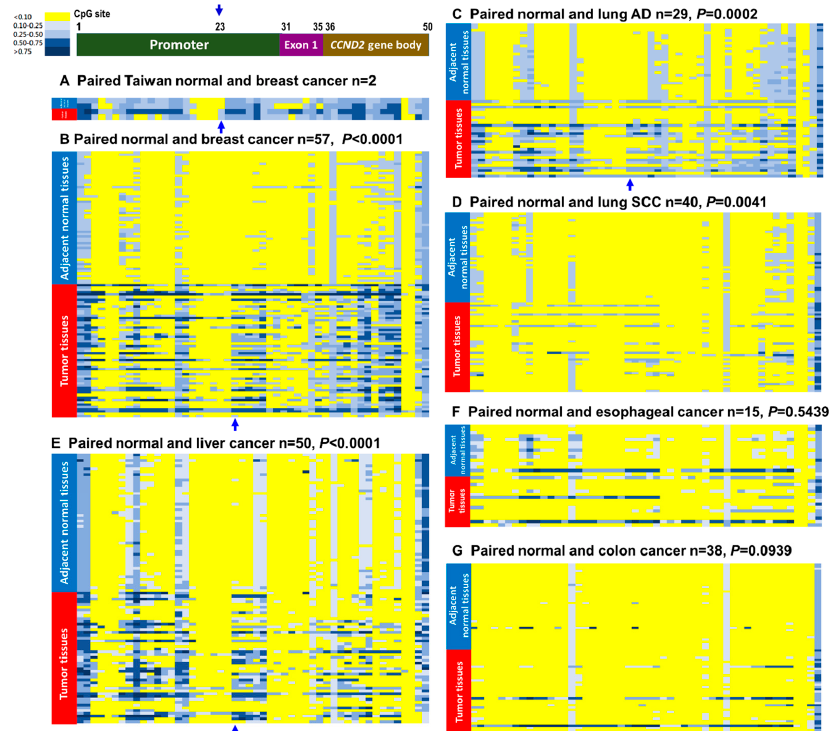
Figure 2. CCND2 methylation pattern in breast, lung, liver, esophageal, and gastric cancers. The 50 CpG sites of the CCND2 methylation levels from the promoter region (30 CpG sites), exon 1 region (5 CpG sites), and gene body region (15 CpG sites, sites 36–46 on intron 1, sites 47–49 on intron 2, site 50 on intron 4) were identified using the Illumina Methylation 450K array-based assay. The CCND2 gene is located on chromosome 12. Positions of CpG from 1 to 50 are located from 4381435 to 4390091 of chromosomes 12. ( A ) Paired breast tumors and adjacent normal tissues from breast cancer patients. The red arrow indicates the differential site between breast normal and cancerous tissues. ( B ) The data for methylation patterns were collected from The Cancer Genome Atlas (TCGA). Paired cancer and adjacent normal tissues were obtained from breast cancer ( n = 57), ( C ) lung adenocarcinoma ( n = 29), ( D ) lung SCC ( n = 40), ( E ) liver cancer ( n = 50), ( F ) esophageal cancer ( n = 15), and ( G ) colon cancer ( n = 38). The blue arrow indicates the differential sites between breast normal and cancerous tissues. Adjacent normal tissues from patients are marked with blue bars, and tumor tissues are marked with red